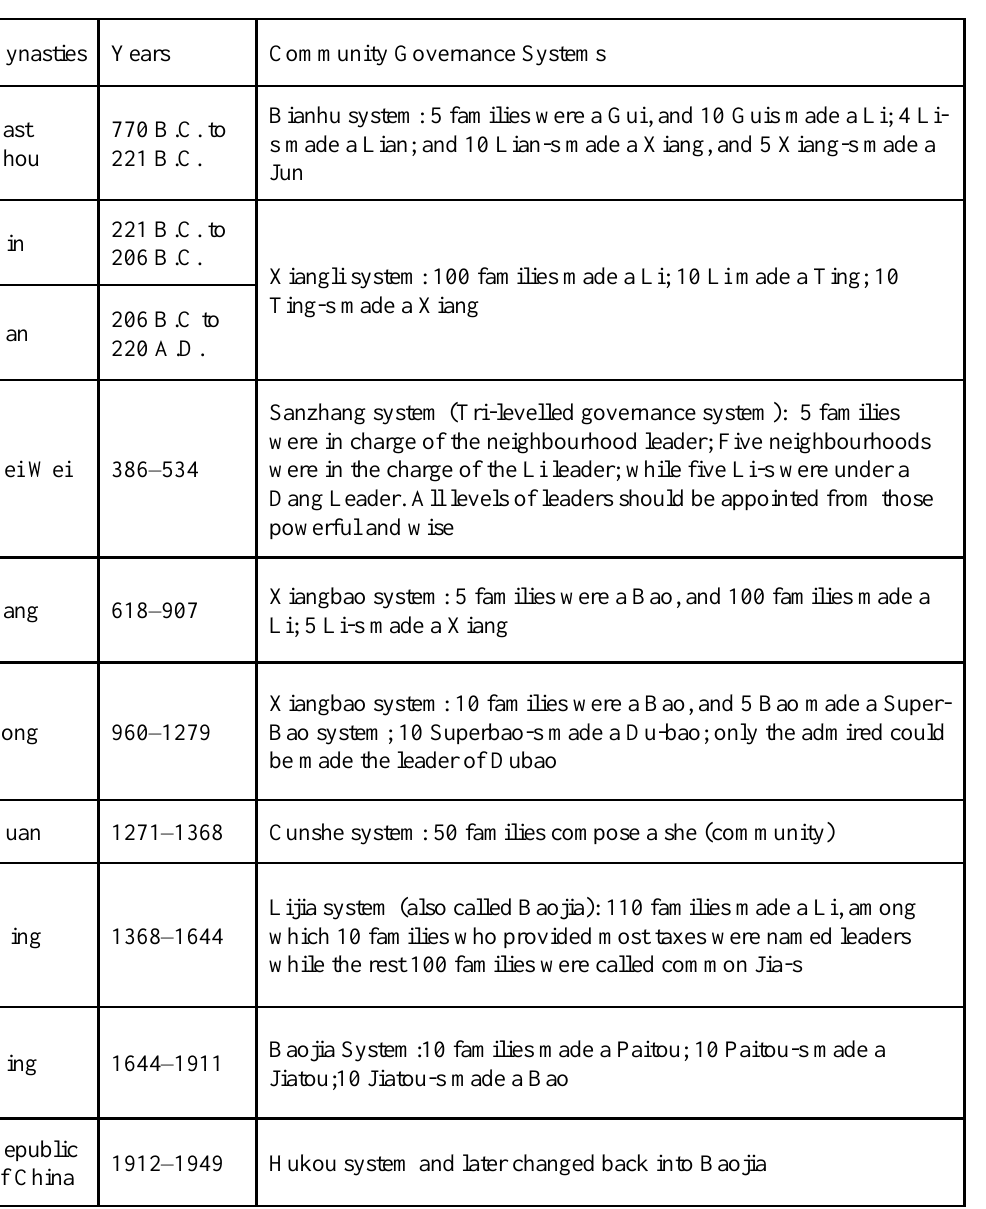
Table 2. Community Governance Paradigm Traditions in Ancient China (developed by the authors, based on Baidu Encyclopaedia.,